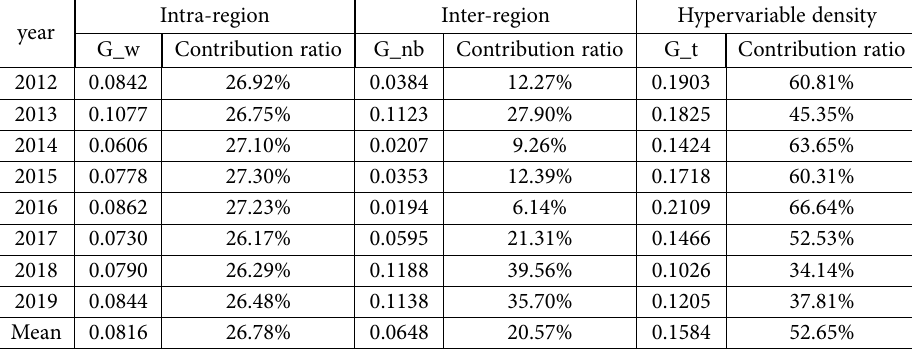
Table 3. The Gini coefficient decomposition of the smart resilience index in